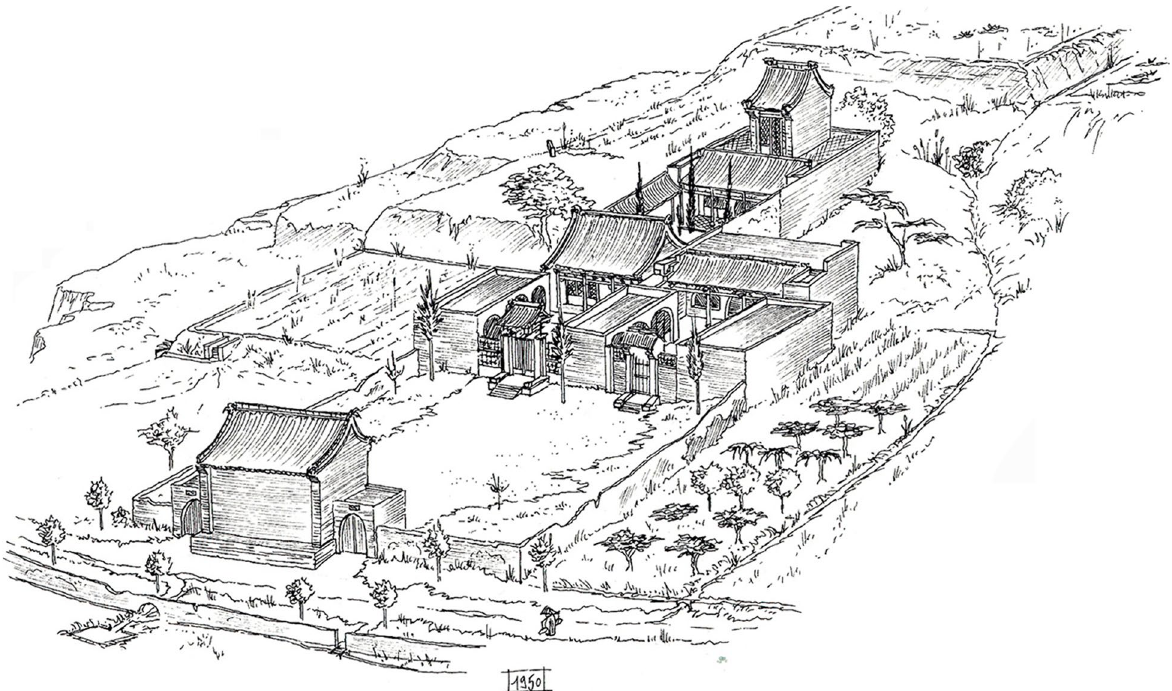
Fig. 9 Layout of Yuanshen Temple (Source: Tongji University and Ecole de Chaillot